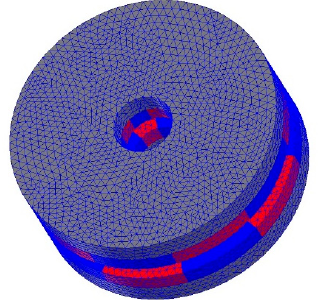
Figure 7. The meshing of the simulation model.